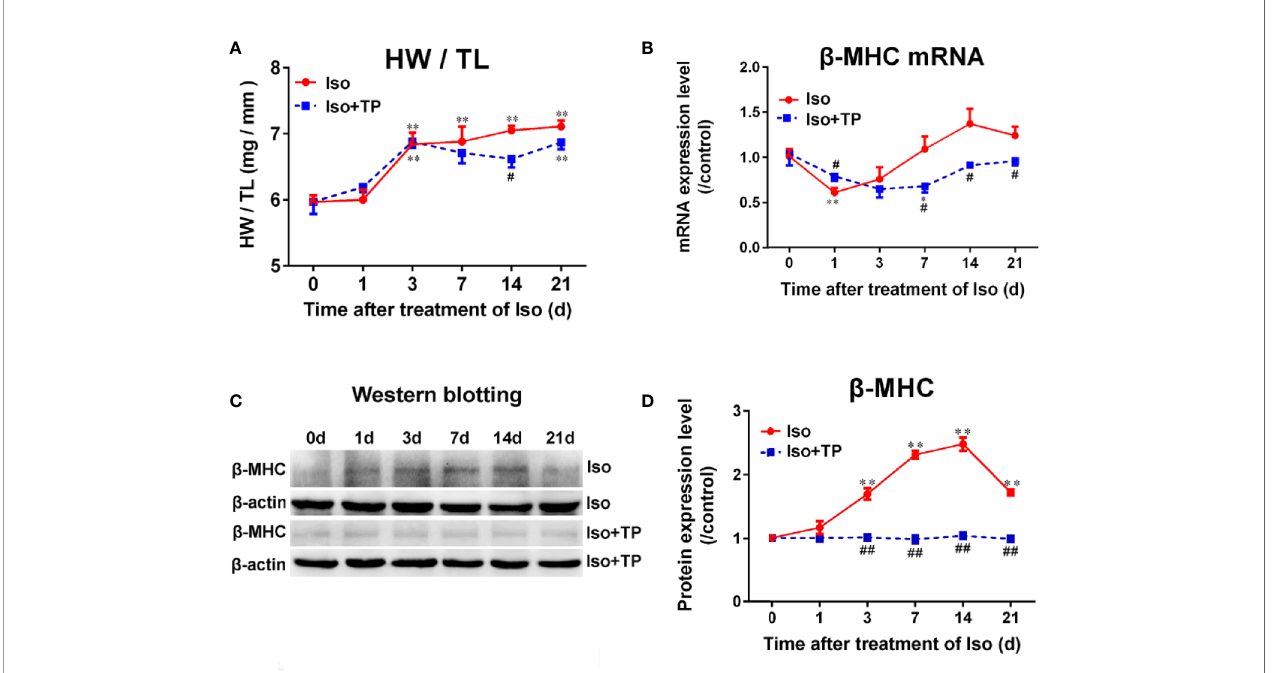
FIGURE 4 | Triptolide attenuated cardiac hypertrophy in mice. (A) Heart weight (HW) index to tibia length (TL). (B) b -MHC mRNA expression level ( n = 6). (C) b -MHC protein level as assessed by Western blot analysis ( n = 4). (D) The intensity of each band was quanti fi ed by densitometry and normalized to b -actin and the control group. Data are shown as the mean ± SEM, *P < 0.05, **P < 0.01 compared with the controls (0 day); # P < 0.05, ## P < 0.01 compared with the Iso-treated group at the same time point (one-way